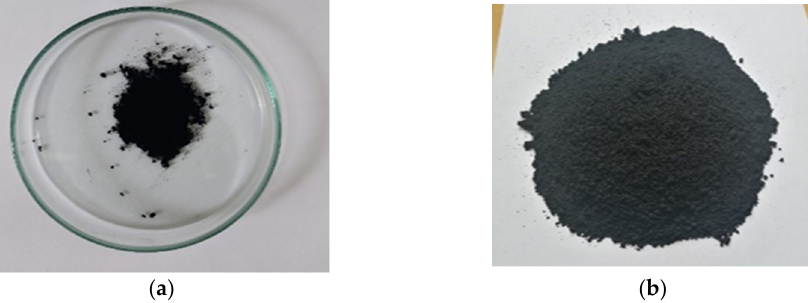
Figure 1. Sample of nano reinforcements; ( a ) carbon fibers and ( b ) MWCNT.